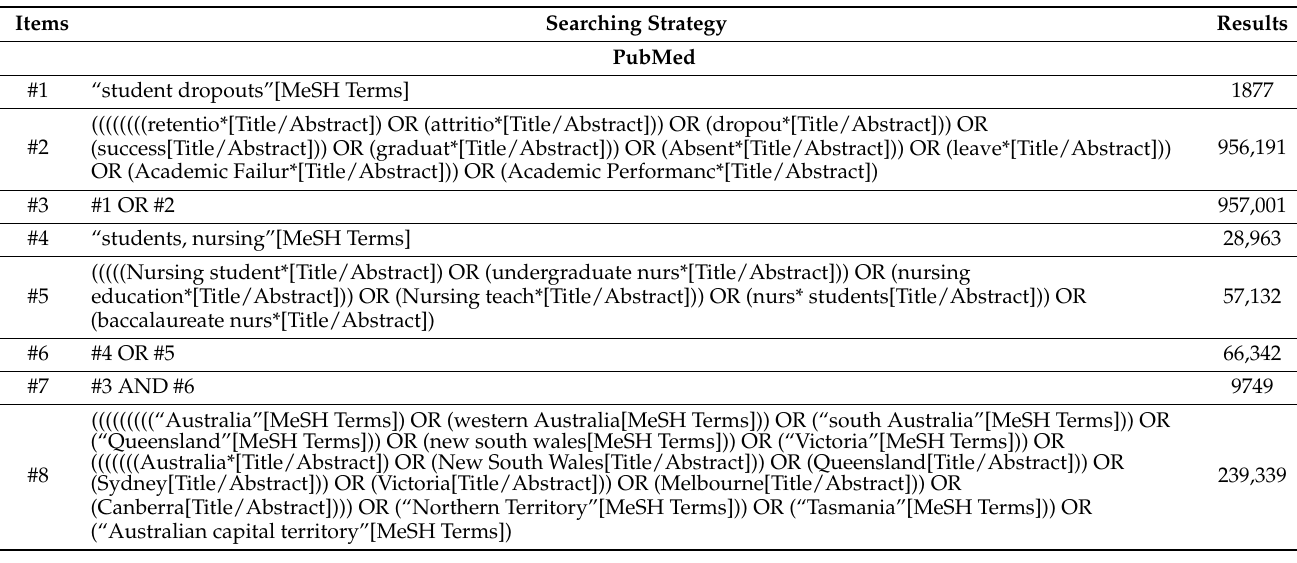
Table A1. Searching